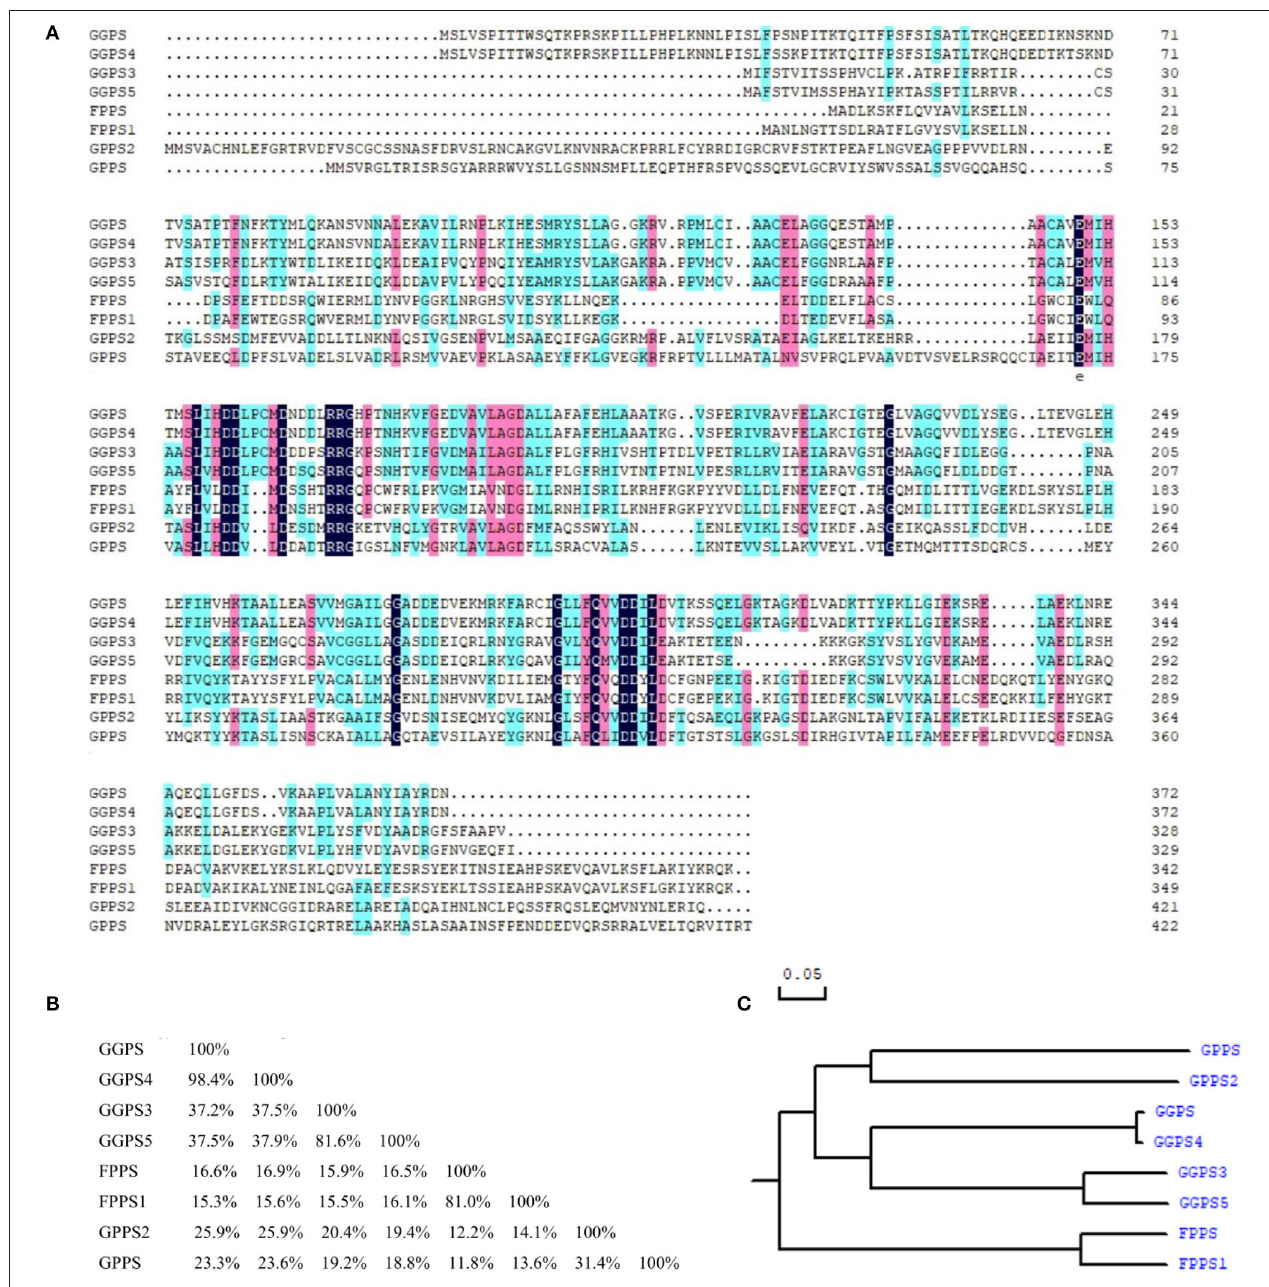
FIGURE 5 | Sequence comparison of FPP/GGPP synthases in R. glutinosa. (A) Sequence alignment of FPP/GGPP synthase in R. glutinosa , (B) Homology matrix of FPP/GGPP synthase in R. glutinosa , (C) Phylogenetic analysis of FPP/GGPP synthase in R. glutinosa